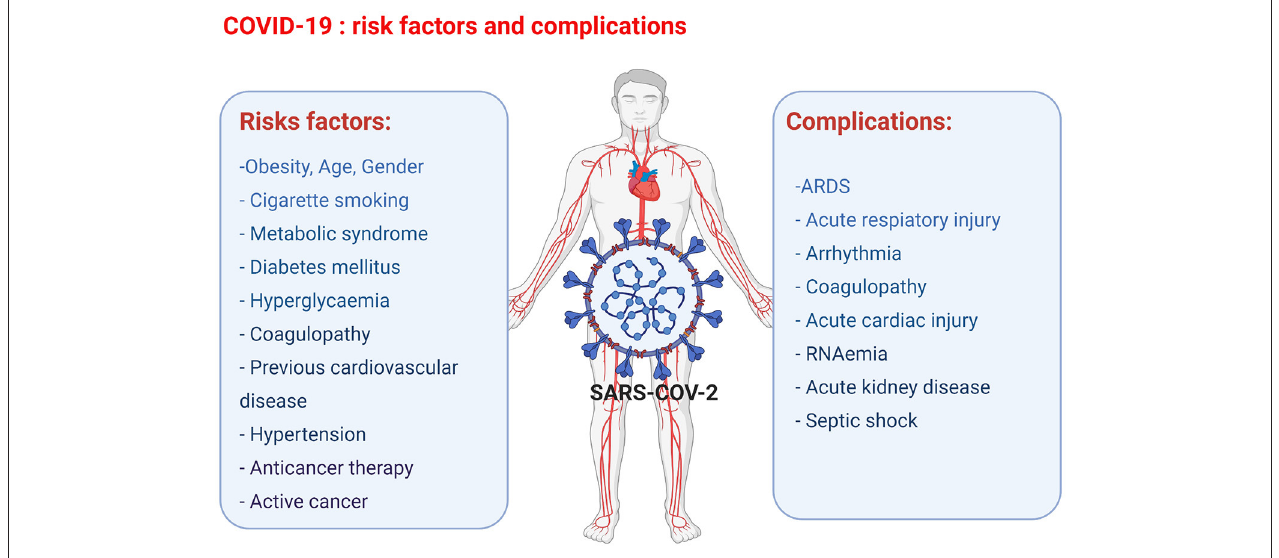
FIGURE 1 | Overview of the COVID-19 risk factors and complications observed in COVID-19 patients leading to cardiac injury (figure created with